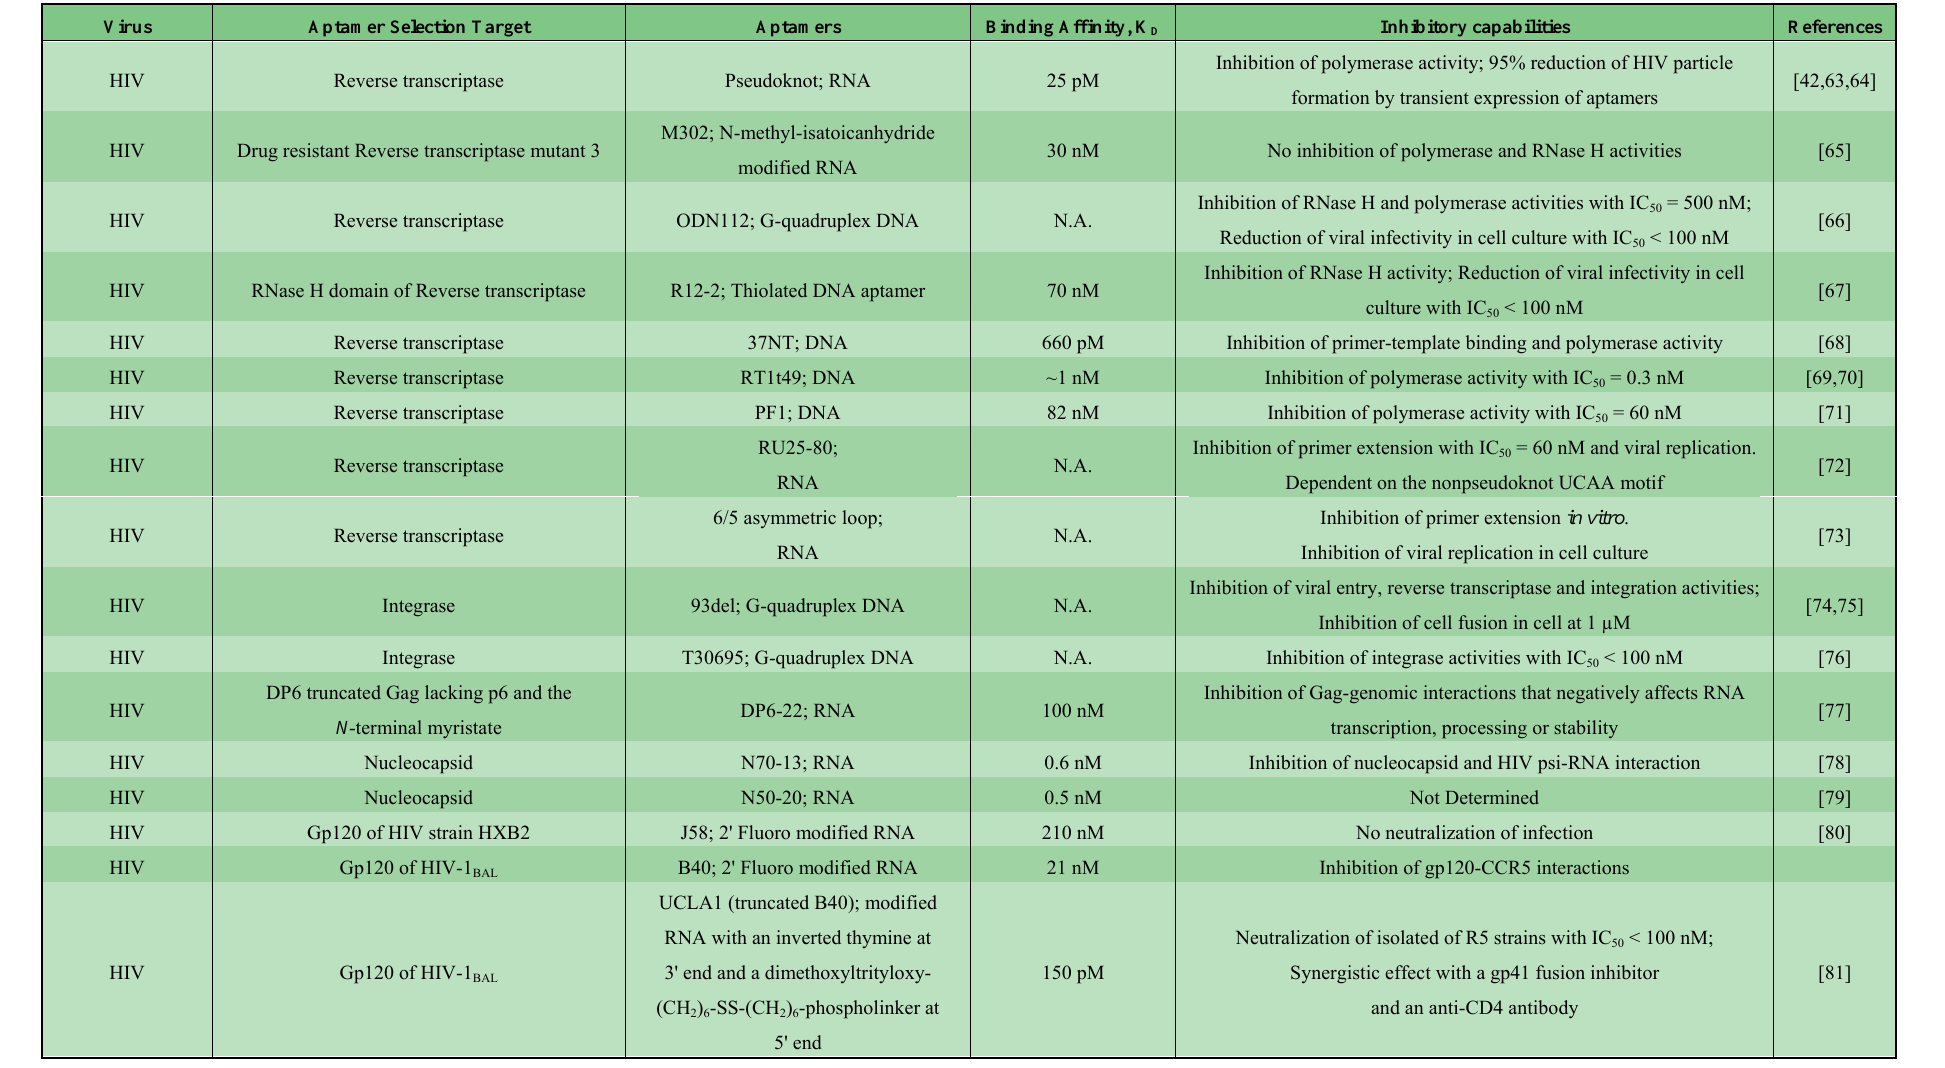
Table 1. List of representative antiviral aptamers and their